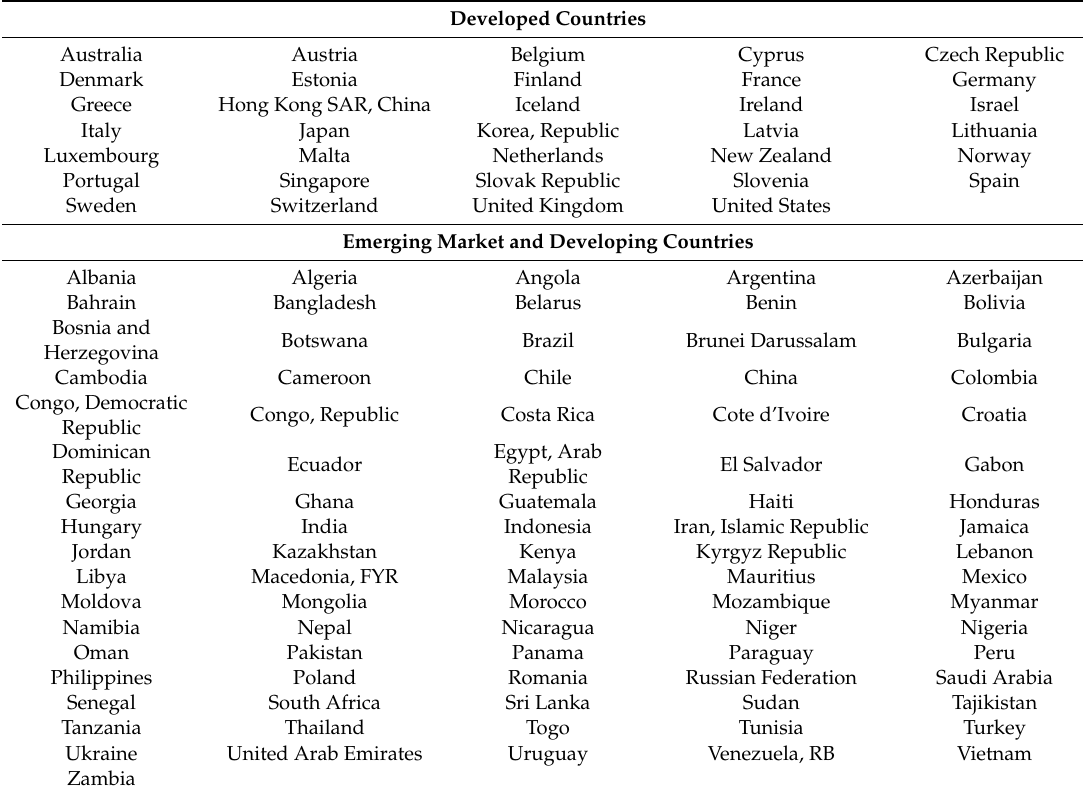
Table A1. Sample countries and